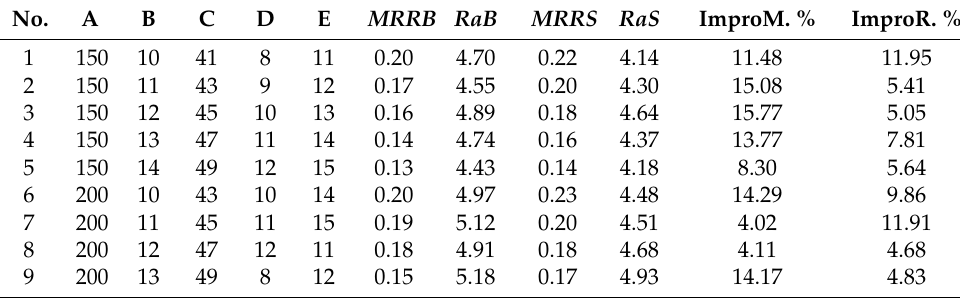
Table 5. Experimental design and